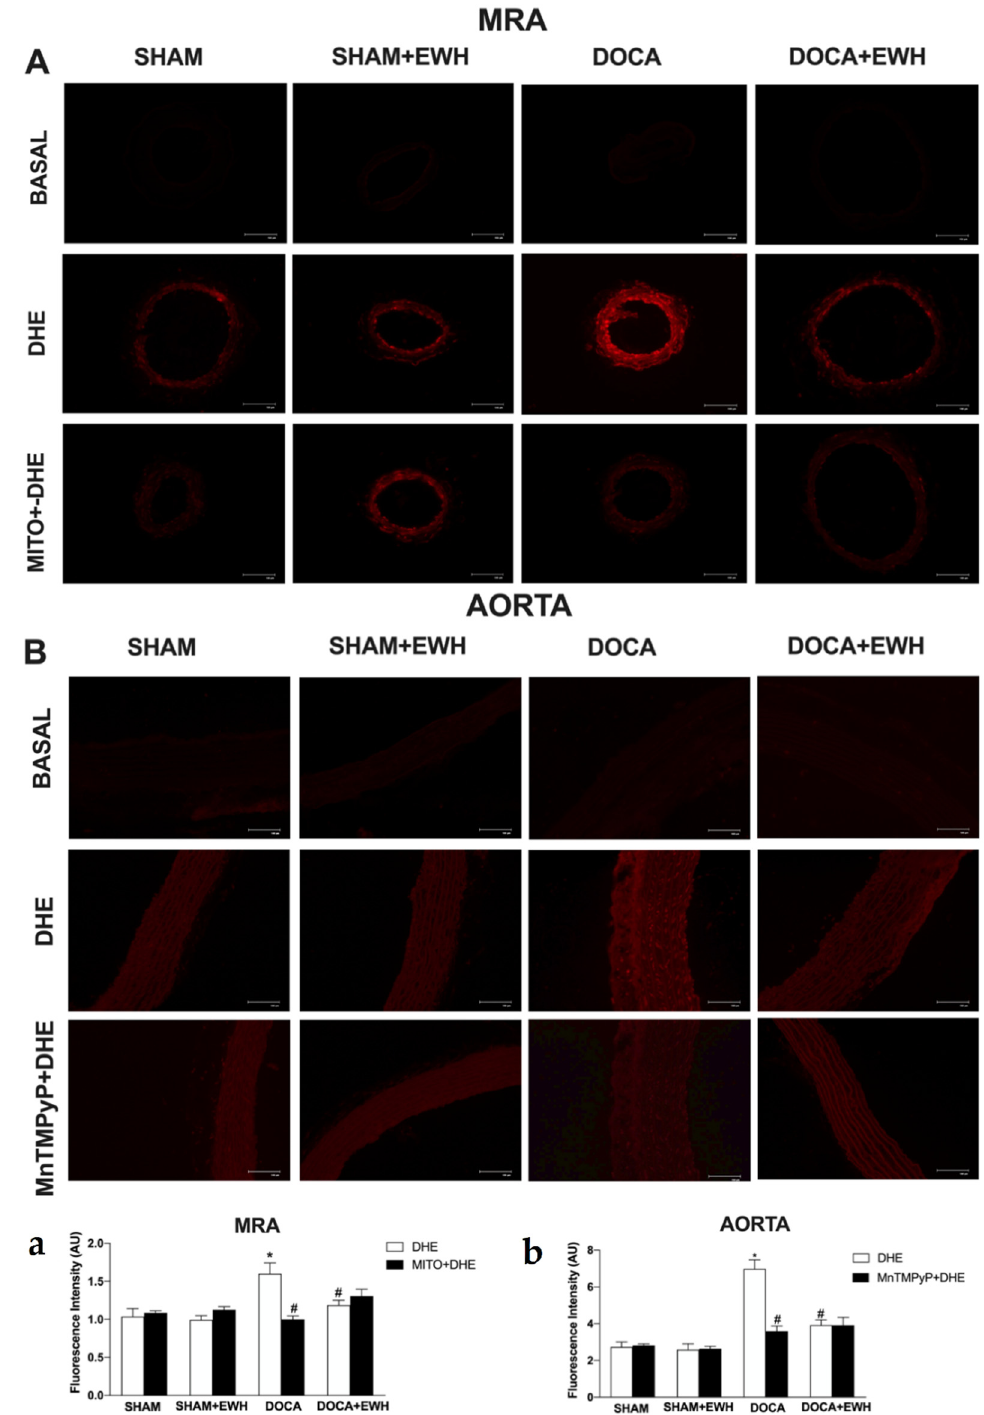
Figure 7. The role of EWH on O 2 − production in MRA and aorta section of DOCA-salt rats. Typical images of sensitive fluorescent dye Dihydroethidium (DHE) in the absence or presence of Mito- TEMPO (0.5 µmol/L—third line panel A ) or MnTMPyP (25 µM—third line panel B ) in MRA and aorta sections of SHAM, SHAM+EWH, DOCA, or DOCA+EWH rats. The basal images are the negative control pictures without DHE. The histogram ( a —MRA and b —Aorta) shows in white bars the DHE fluorescence and in black bars the DHE fluorescence after Mito-TEMPO or MnTMPyP incubation. The results are expressed as representative fluorescence intensity in arbitrary units. The results are expressed as mean ± SEM (n = 6). Two-way ANOVA followed by Bonferroni post-test: p < 0.05 * vs. SHAM; # vs. DOCA.